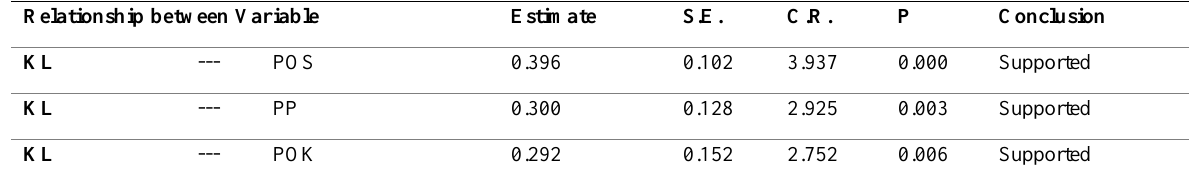
Table 6: Direct Influence between Variable